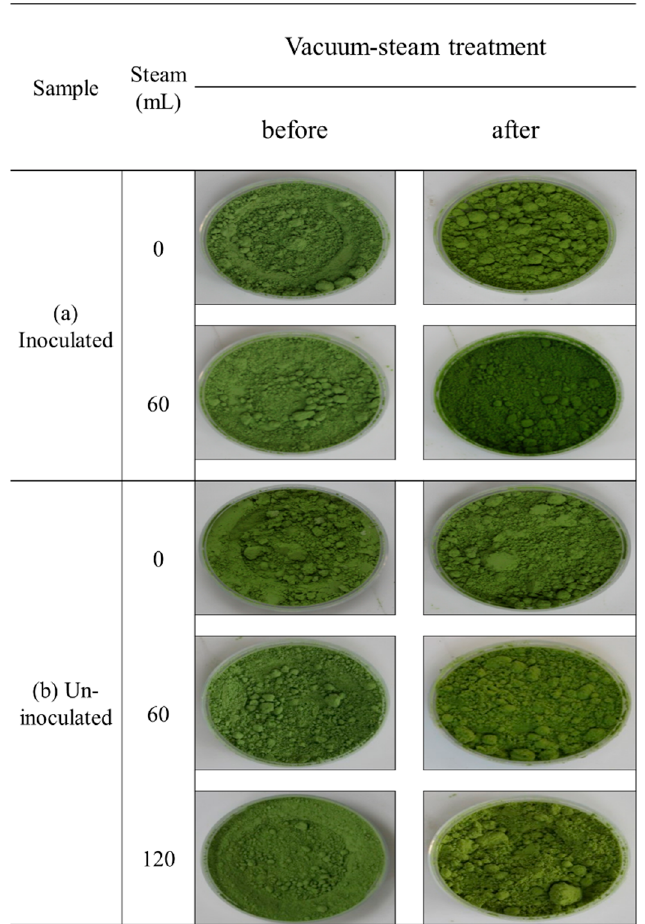
Figure 16. Conditions before and after treatment of ( a ) inoculated and ( b ) un-inoculated sprout barley powder as a function of by vacuum-steam treatment (0, 60, and 120 mL).